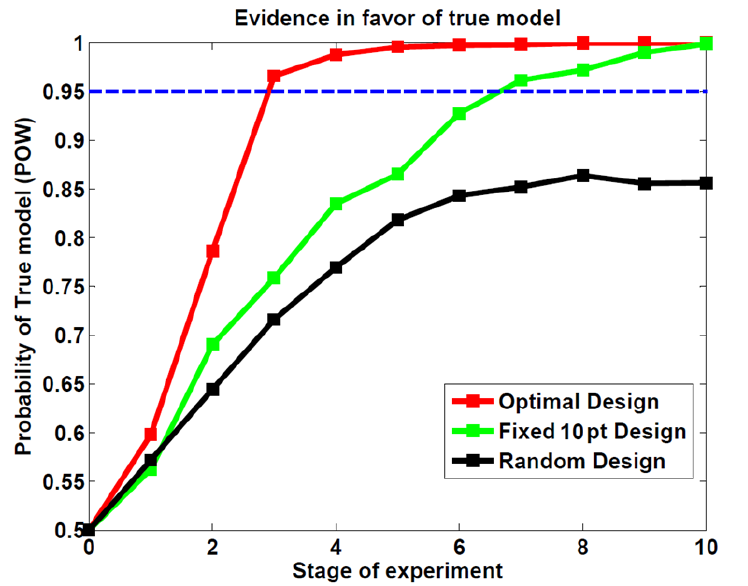
Figure 5. Posterior probabilities of the true (POW) model at each stage (average over 30